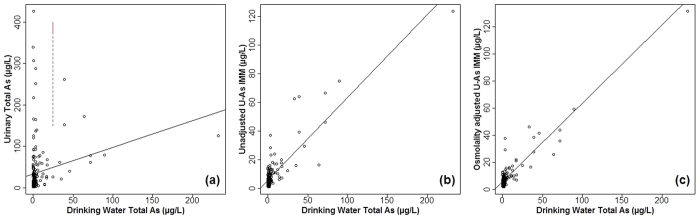
Unadjusted and adjusted urinary As – PWS drinking water As.(a) Unadjusted urinary total As. (b) Unadjusted U-AsIMM (adjusted for AB). (c) Osmolality adjusted U-AsIMM. Linear regression lines are for reference only. A poor relationship between drinking water total As and unadjusted urinary total As is evident (a) due to seafood intake and the large contribution of AB on urinary total As results. This is illustrated by the red dashed line showing high urinary total As results at low drinking water As exposure.